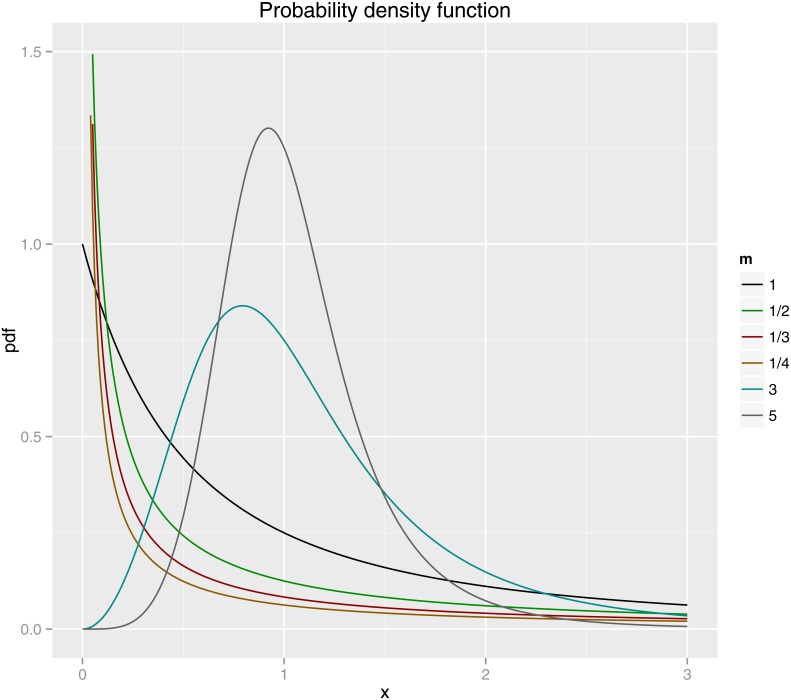
Pdf of the Lavalette distribution.Some Lavalette probability density functions (Eq (4)) with identical parameter C = 1 but with a = 1/5, 1/3, 1, 2, 3, and 4 (m = 1/a = 1/b).